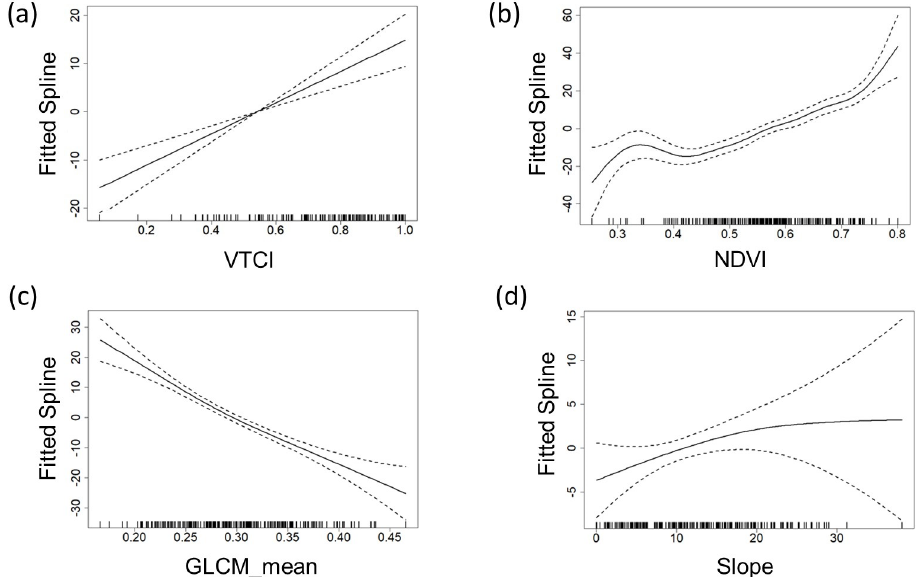
Figure 4. Explanatory variables with significant contribution to the respective binomial response variables. Each plot shows the relationship of the fitted function to the response and scaled to zero. The plots include approximate 95% pointwise. VTCI, Vegetation Temperature Condition Index; NDVI, Normalized Difference Vegetation Index; GLCM_mean, mean of Grey ‐ Level Co ‐ Occurrence Matrix.